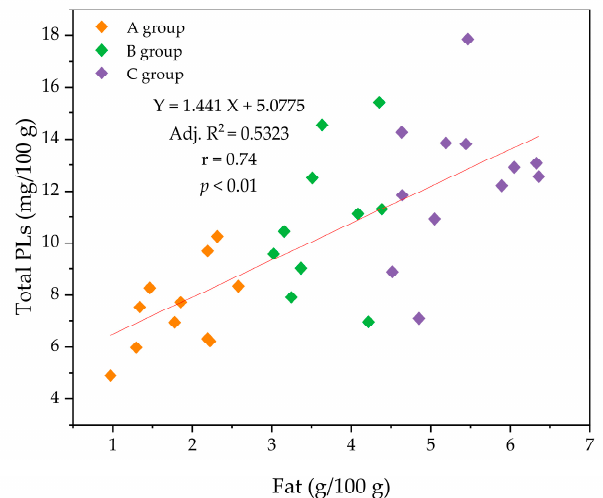
Figure 5. Correlation ( r ) between the concentrations of total phospholipids (PLs) and fat in human milk.